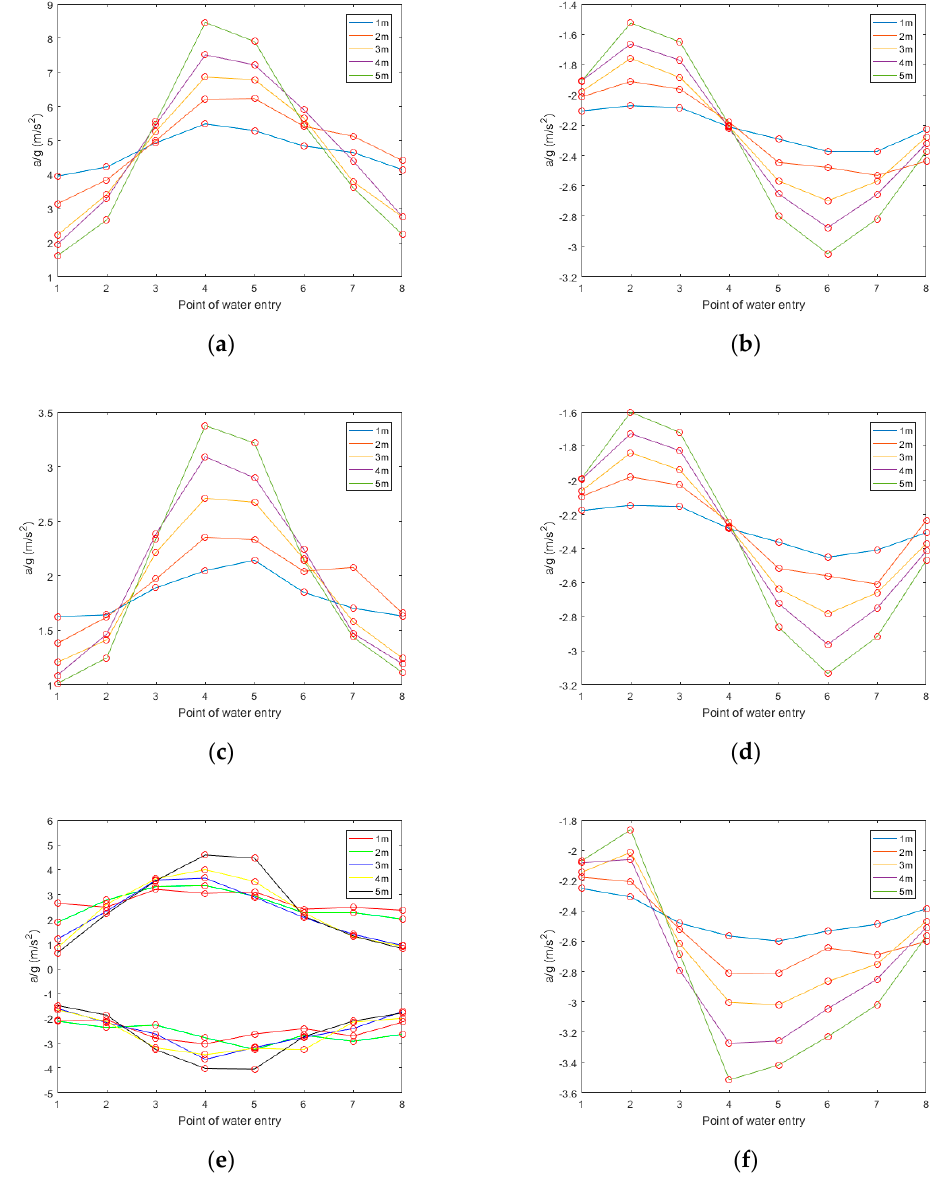
Figure 24. The maximum acceleration of the bow, midship, and stern in the coordinate system of the